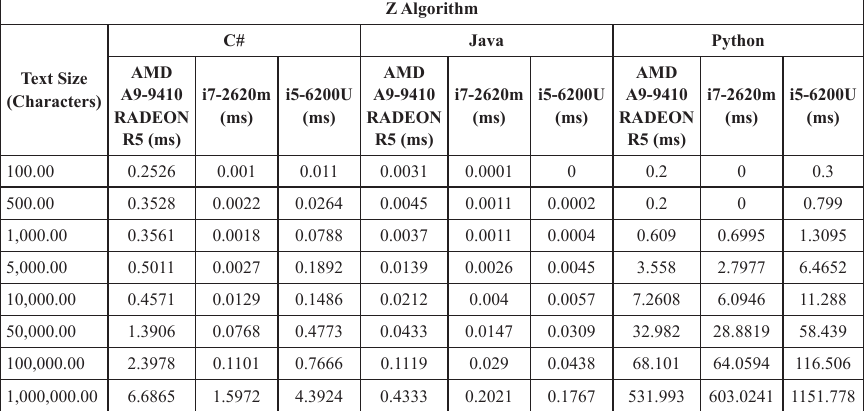
Table 8. Running time of Z algorithm in C#, Java and Python programming languages Z